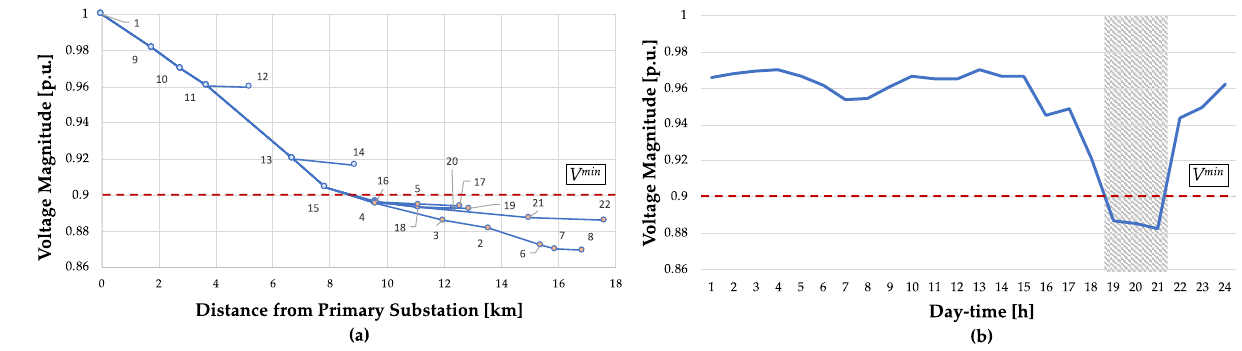
Figure 8. ( a ) Network profile of the minimum nodal voltage at the 19th hour during the emergency configuration with